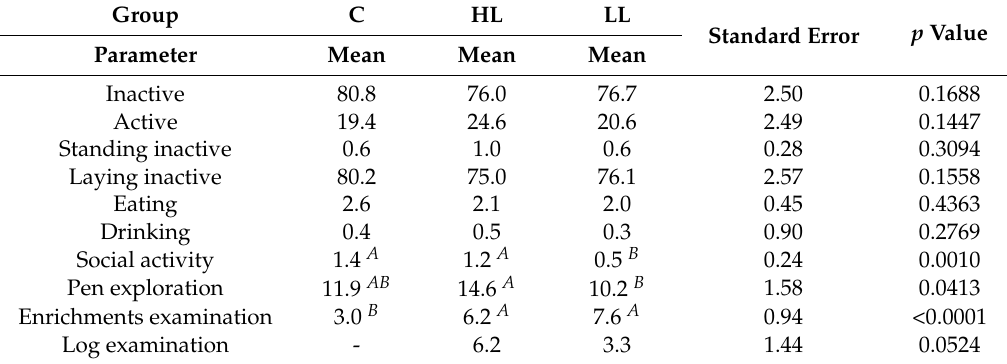
Table 3. Behavioural observations (%) by